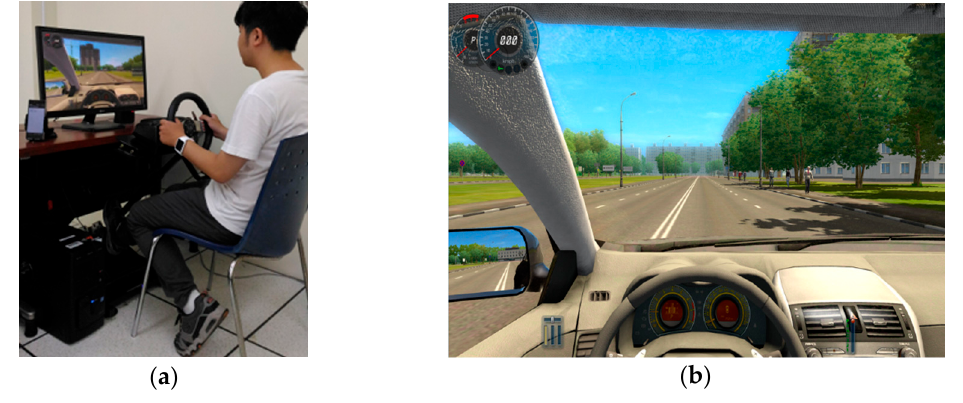
Figure 1. ( a ) Driving simulation system. ( b ) Simulated road scene.